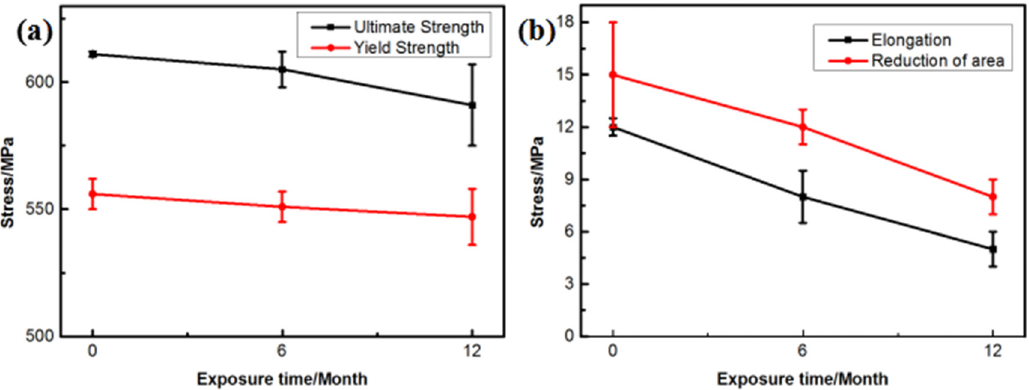
Figure 9. Tensile properties of the 7075 alloy exposed to the marine atmospheric environment at different time points: ( a ) strength and ( b ) plasticity.